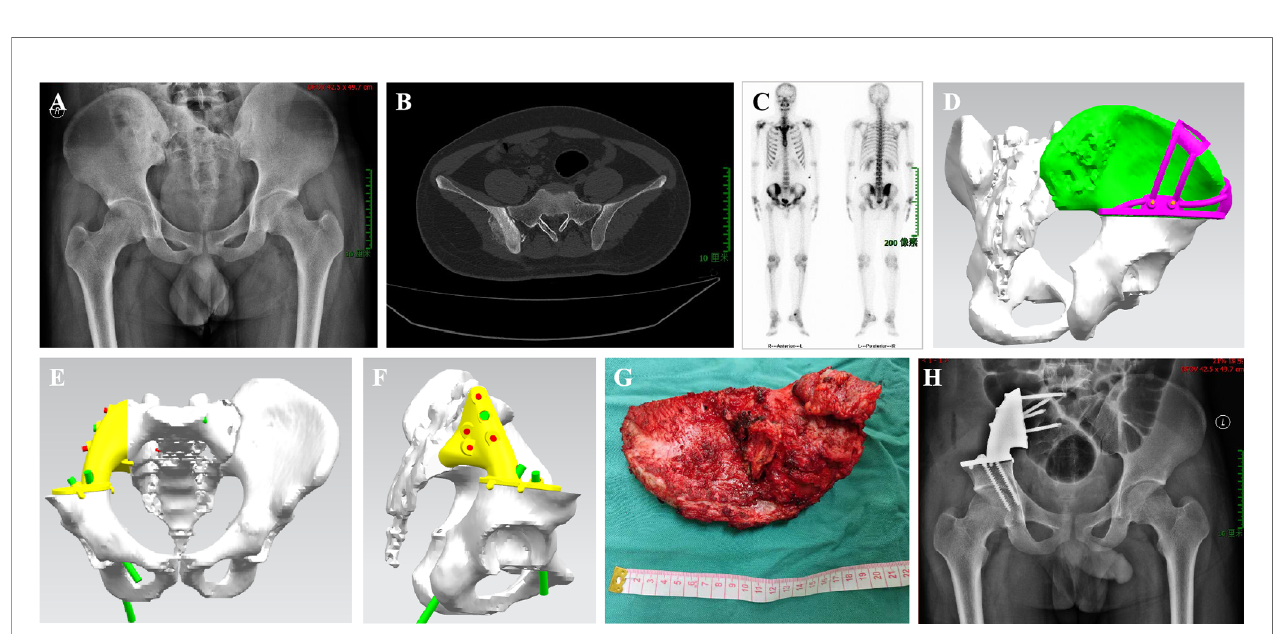
FIGURE 4 | A 56-year-old male patient with recurrent osteosarcoma. (A) Preoperative X-ray shows a right sacroiliac joint tumor. (B) Preoperative magnetic resonance imaging (MRI) shows a right sacroiliac joint tumor. (C, D) Design and simulated installation of 3D-printed prosthesis. (E) Installation of 3D-printed osteotomy guide plate. (F) General view of the specimen. (G) Installation of 3D-printed prosthesis. (H) Twenty- fi ve months postoperative X-ray shows the prosthesis was fi tted precisely to the residual bone. (I) Twenty- fi ve months postoperative computed tomography (CT) showed signi fi cant bone in-growth at the bone-prosthesis